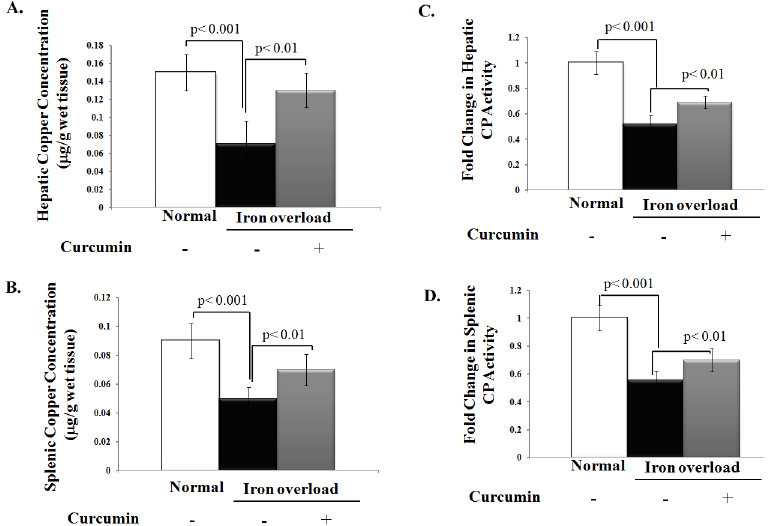
Fig 5. Curcumin ’ s modulation of copper content and antioxidant protein (ceruloplasmin) activity in liver and spleen of iron overloaded rats (A, B). Levels of copper in both liver and spleen homogenates of iron overloaded rats treated with or without curcumin; ( C, D) ceruloplasmin activity (U/g tissue) in liver and spleen relative to normal control, which was assigned a value of 1. Compared to the corresponding values of the control rat group, the administration of curcumin in iron overloaded rats significantly enhanced the decrease in copper levels and ceruloplasmin activity in both liver and spleen homogenates. Data shown are the mean ± SD (n =